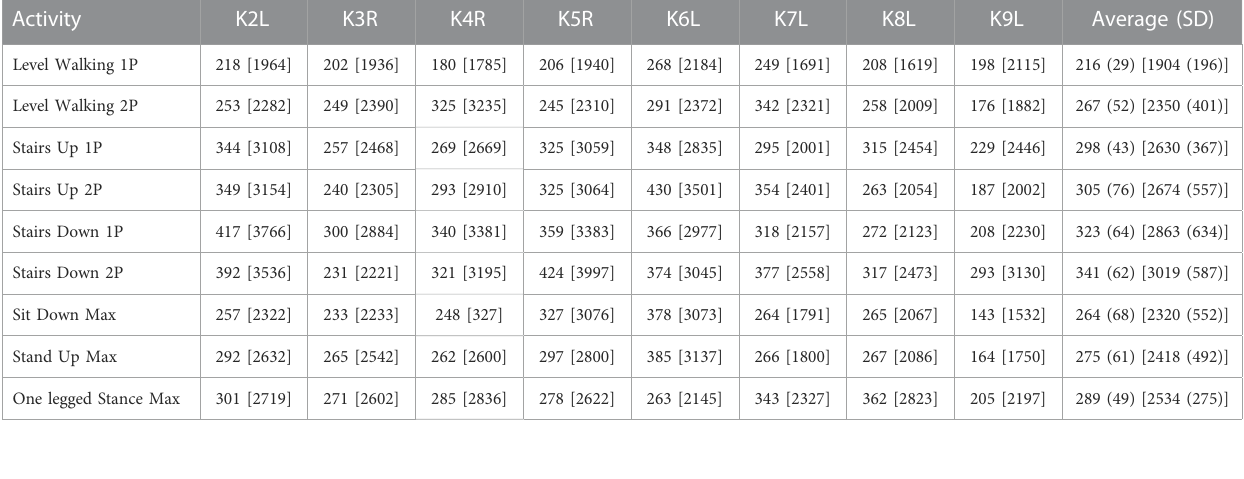
TABLE 3 Patient-speci fi c in vivo tibio-femoral joint loads in % BW [N] during functional activities. 1P — fi rst load peak; 2P — second load peak; SD — standard deviation.